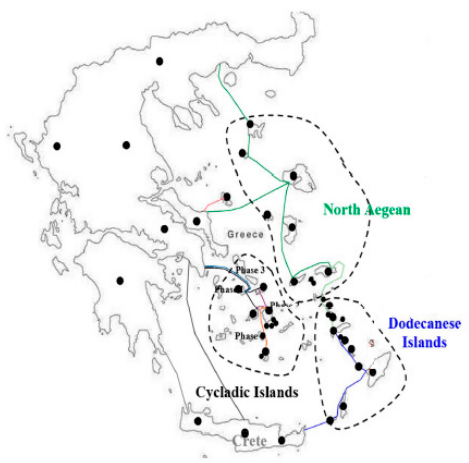
Figure 2. Interconnection plans of Greek islands [25].